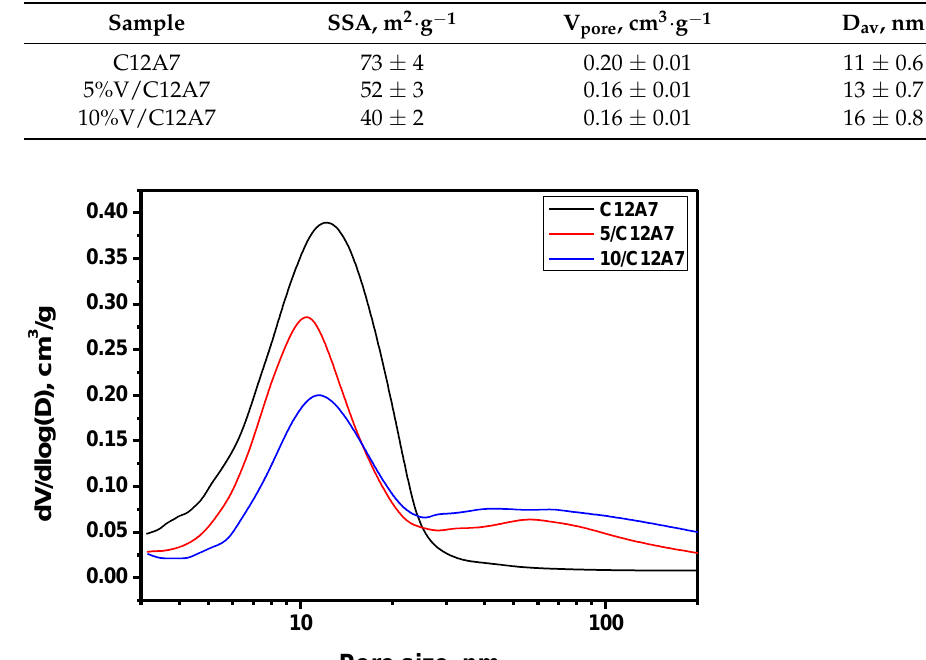
Table 1. Textural characteristics of C12A7, 5%V/C12A7, and 10%V/C12A7 samples.